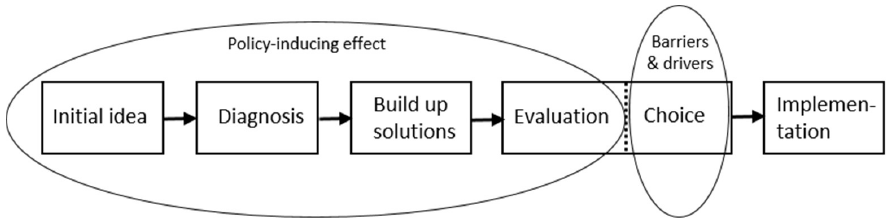
Figure 2. Analytical model based on the investment decision-making model by Cooremans [11].